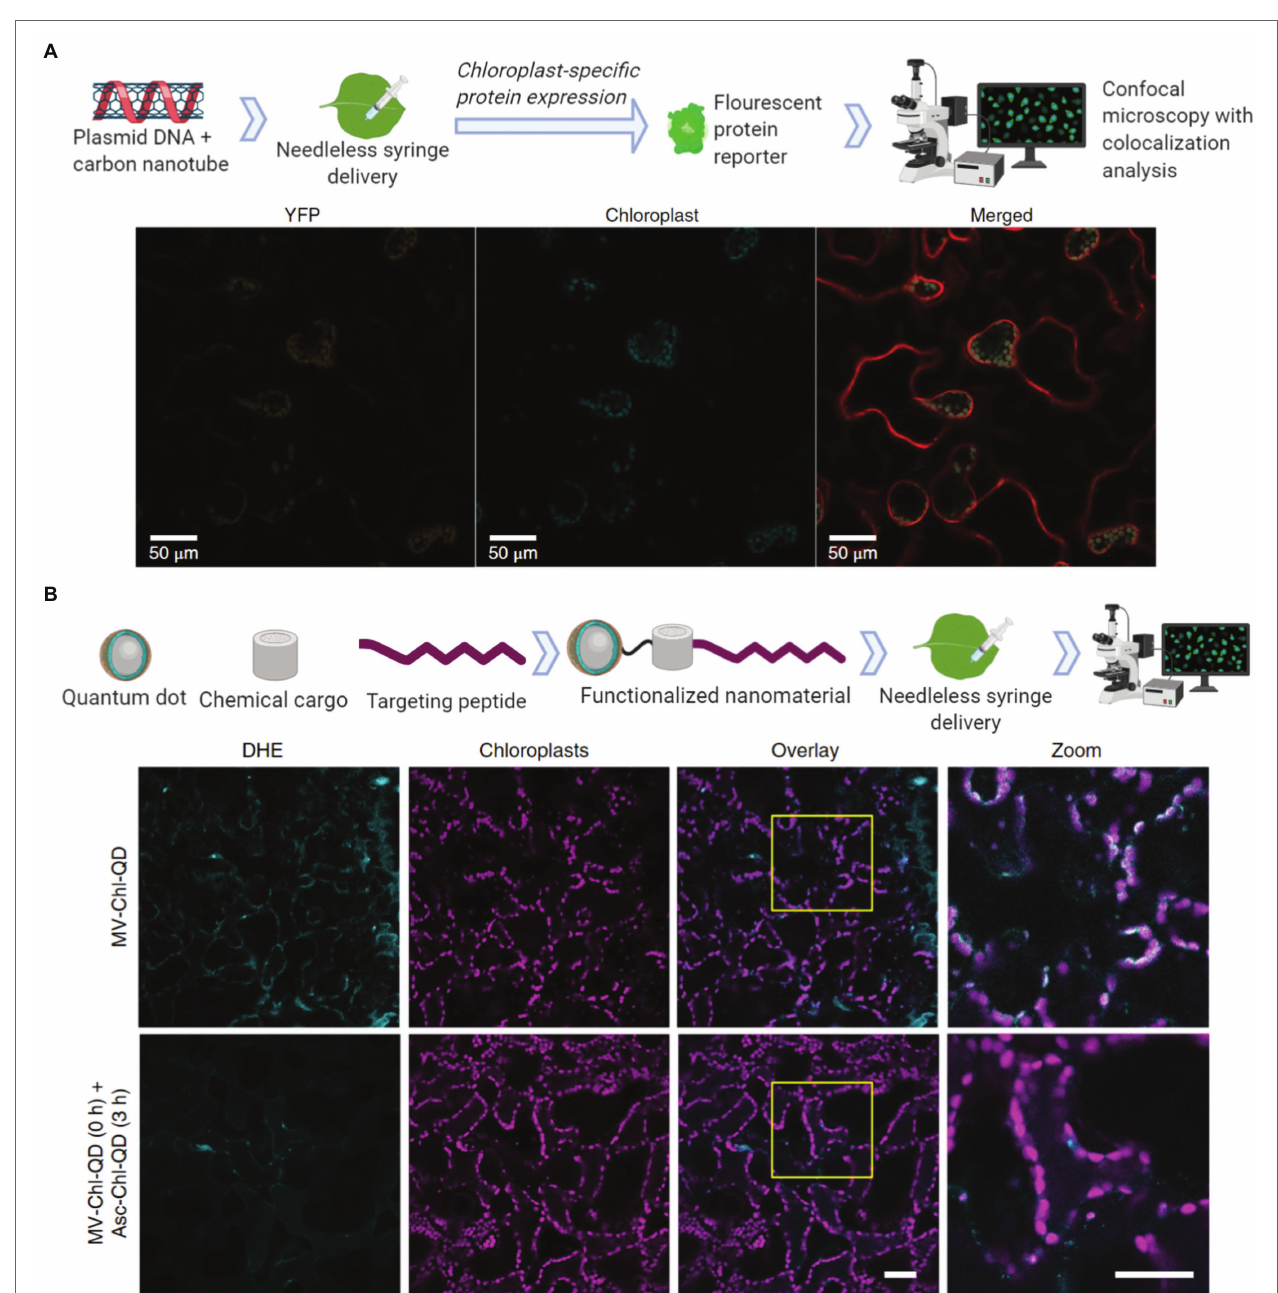
FIGURE 4 | Nanomaterial mediated delivery of DNA and chemical cargoes to chloroplasts. (A) Single walled carbon nanotubes coated with chitosan carry plasmid DNA to chloroplasts. The nanomaterials are infiltrated into leaf mesophyll cells with a needless syringe. Confocal microscopy was then used for colocalization analysis 2–3 days post-infiltration by measuring the chloroplast-specific fluorescent protein (YFP) expressed within the mesophyll cells of tobacco plants (Material from Kwak et al., 2019). (B) Quantum dots with molecular baskets target the delivery of a chemical cargo to chloroplasts guided by a peptide recognition motif (Chl-QD). These functionalized nanomaterials were then loaded with methyl viologen (paraquat; MV-Chl-QD) to generate superoxide anion within chloroplasts or ascorbic acid (Asc-Chl-QD) to scavenge the superoxide anion. By monitoring reactive oxygen species (ROS) through the DHE dye using confocal microscopy, the targeted nanomaterials were shown to specifically induce and scavenge ROS in vivo in chloroplasts. Scale bar, 40 μ M (Material from Santana et al.,